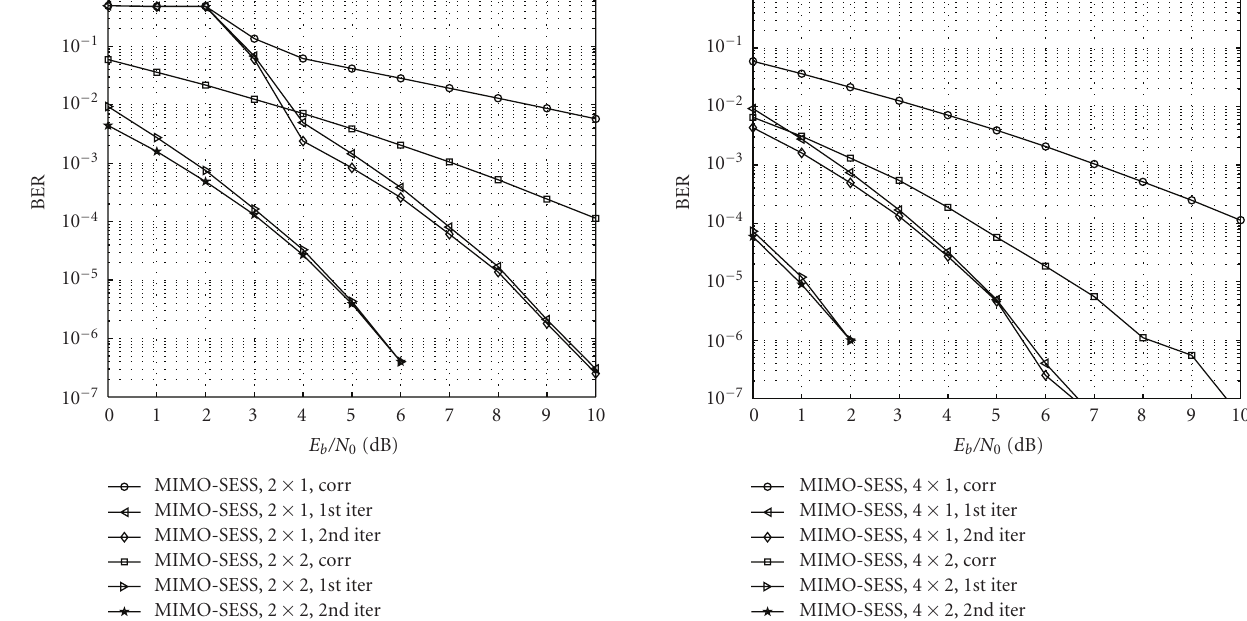
Figure 5: Performance of the proposed MIMO-SESS system with iterative detection, two transmit antennas using full-rate code G 2 , N = 64.